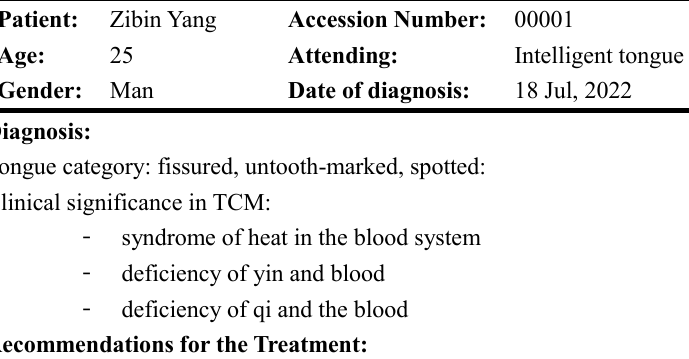
Figure 3. Tongue diagnosis